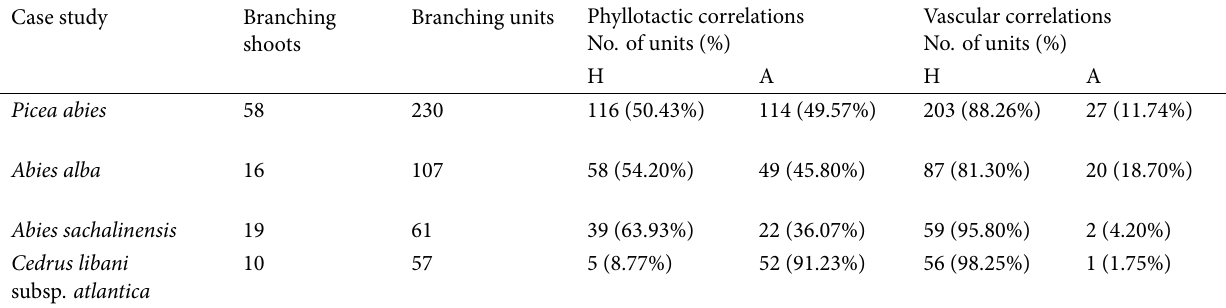
Table 1 Frequency of chiral homodromic (H) and antidromic (A) correlations in studied plant material. Case